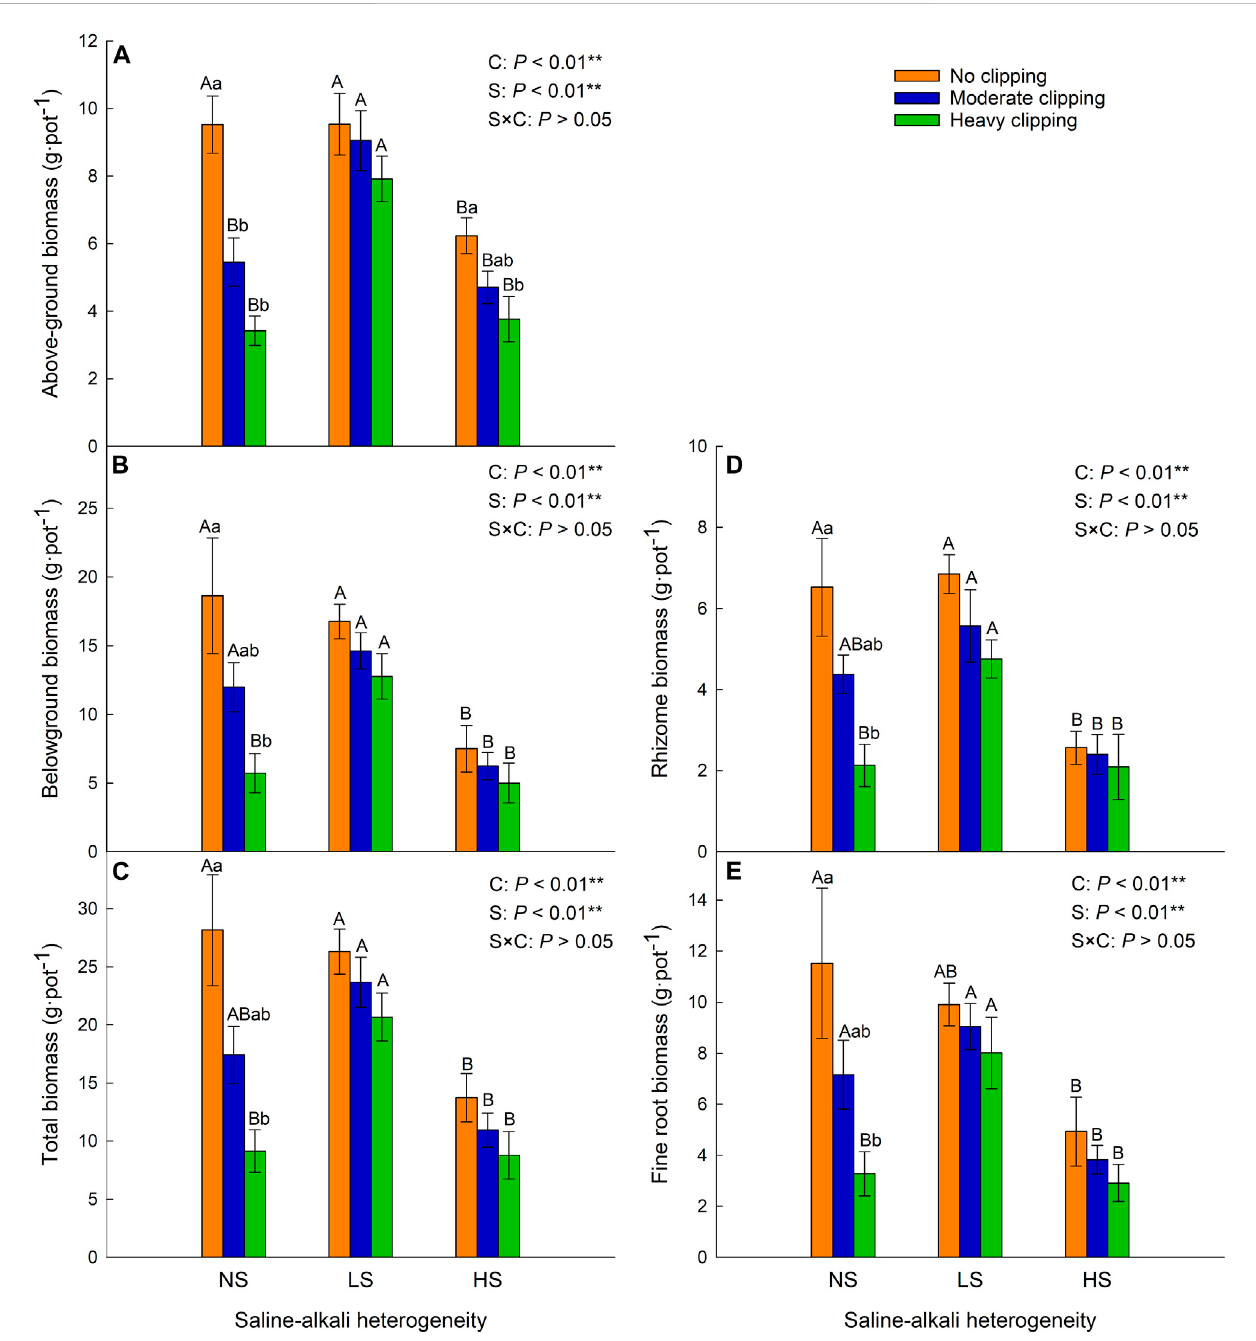
FIGURE 2 Effects of saline-alkali heterogeneity (S), clipping (C) and their interaction (S×C) on the above-ground biomass (A) , belowground biomass (B) , total biomass (C) , rhizome biomass (D) and fi ne root biomass (E) of L. chinensis. Different lowercase letters represent signi fi cant difference ( p < .05) of the clipping treatments in the same saline-alkali stress, and different uppercase letters represent signi fi cant difference ( p < .05) of the saline-alkali heterogeneity in the same clipping